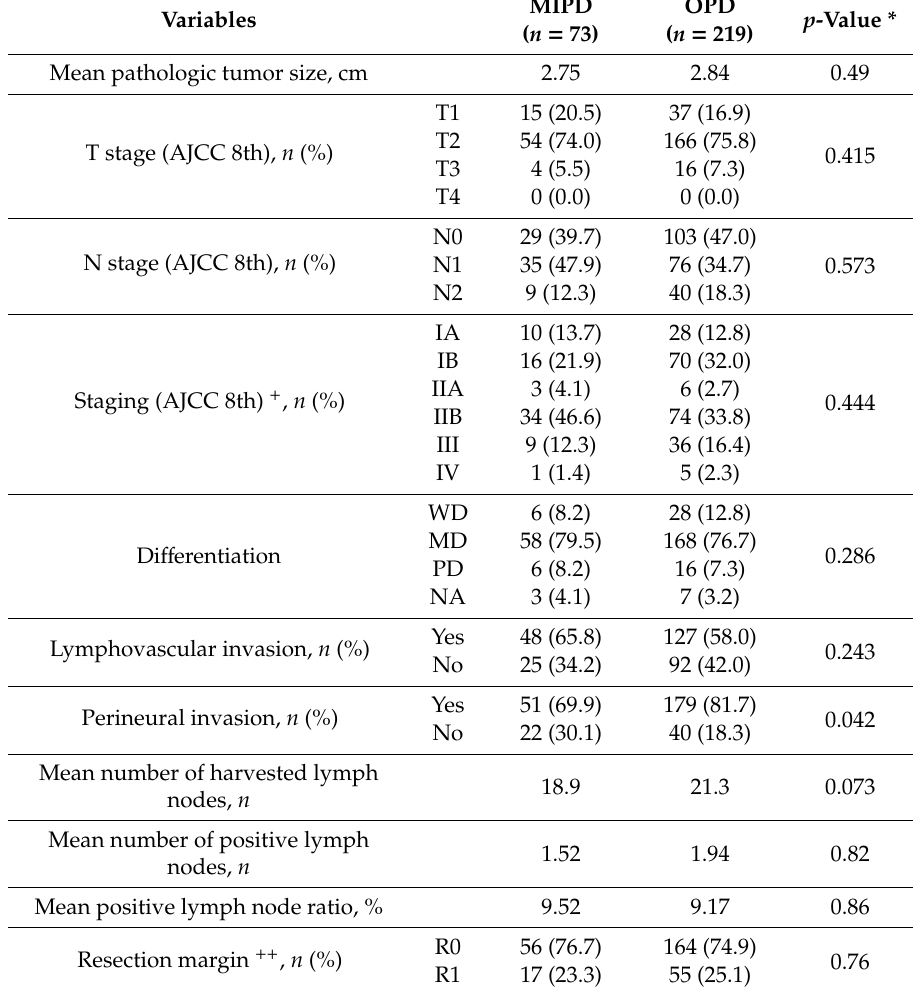
Table 6. Pathologic outcome of MIPD and OPD after propensity score